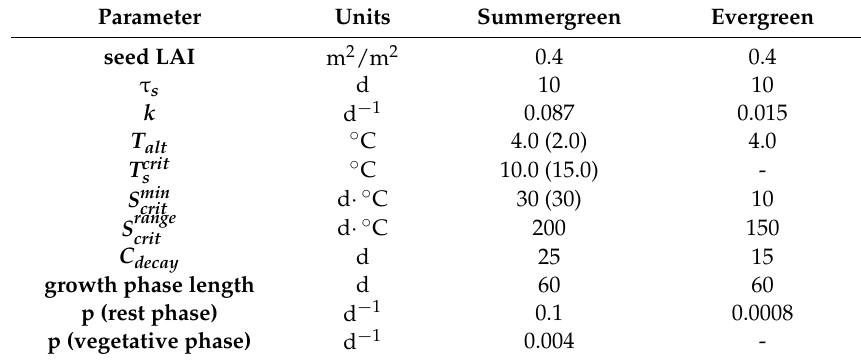
Table A1. Parameters of the evergreen and summer-green phenological models of LoGro-P used in this study. Parameter values for the alternating temperature ( T alt ), the characteristic time for memory loss for computation of the pseudo soil temperature ( Ts ) and the minimum value of the critical heat sum ( S min ) were varied for sensitivity tests. Parameter values that produced zero bias in the start date crit of season for deciduous forest when compared to satellite observation of DBF_SOS sat in Finland are given in brackets.